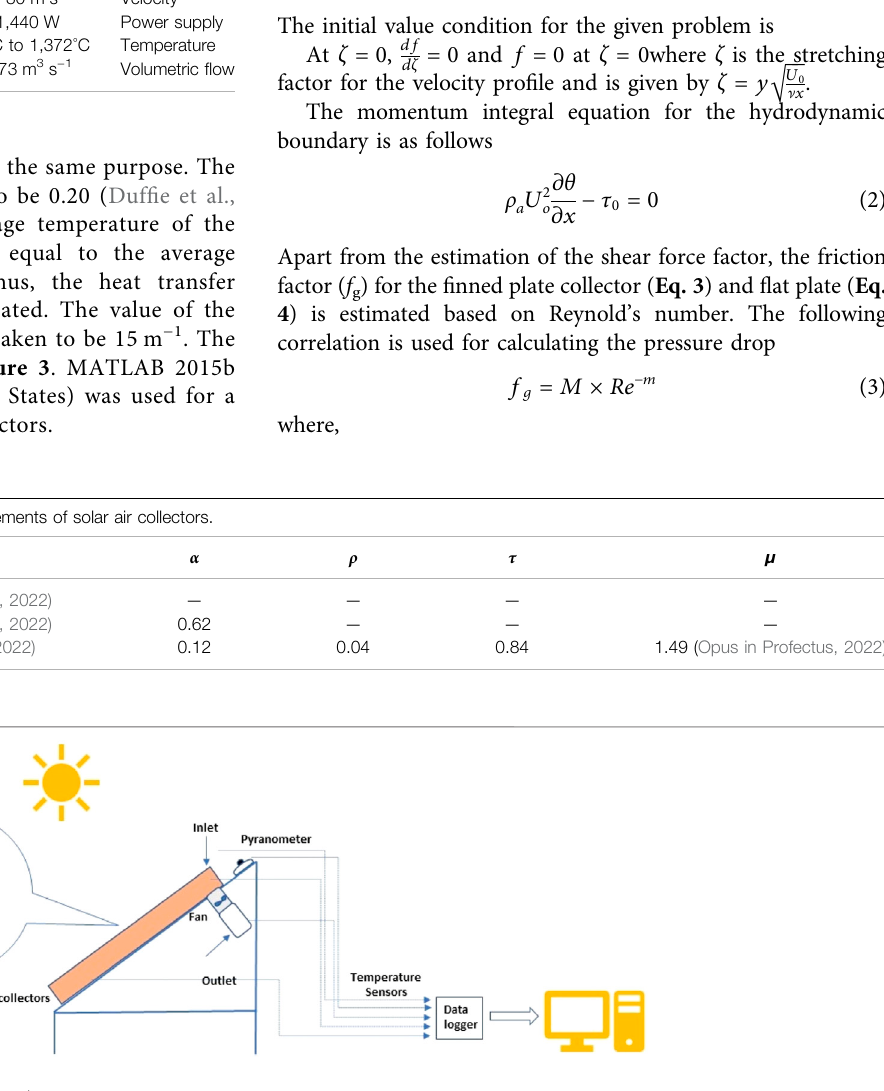
FIGURE 3 | Schematic diagram of the experimental